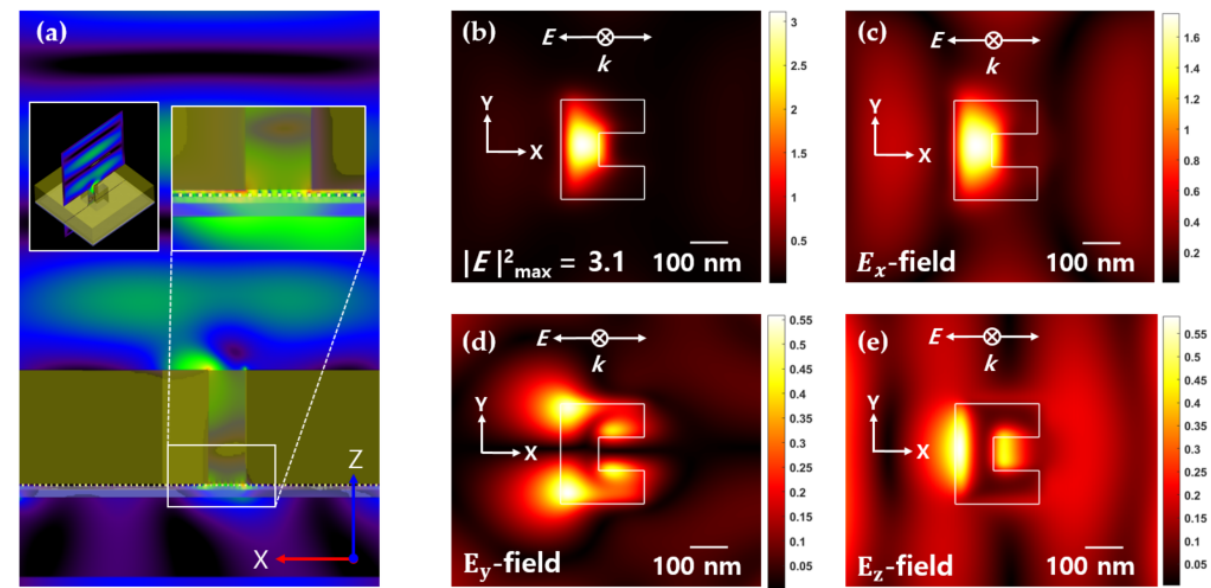
Figure 6. FDTD simulation results of the ridge-type nanoaperture with the Au NPs array deposited media from the bottom of the ZnS-SiO 2 layer. (Cube-type size of NP = 5 nm × 5 nm × 5 nm, Gap = 5 nm, Space = 10 nm): ( a ) E -field distribution in the x-z plane; ( b ) | E | 2 in the x-y plane; ( c ) E x in the x-y plane; ( d ) E y in the x-y plane; ( e ) E z in the x-y plane.